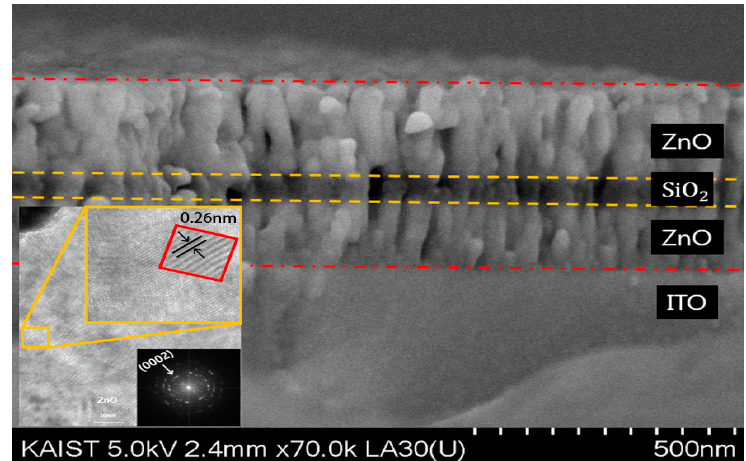
Figure 7. Cross-sectional scanning electron microscope (SEM) image of a typical ZSZ-MG sample fabricated in this work. The inset shows a high-resolution transmission electron microscope (HRTEM) image of the ZnO film along with its selected area electron diffraction (SAED) pattern. Table 2. Average thickness of each film layer in ZSZ-MGs in Figure 6.